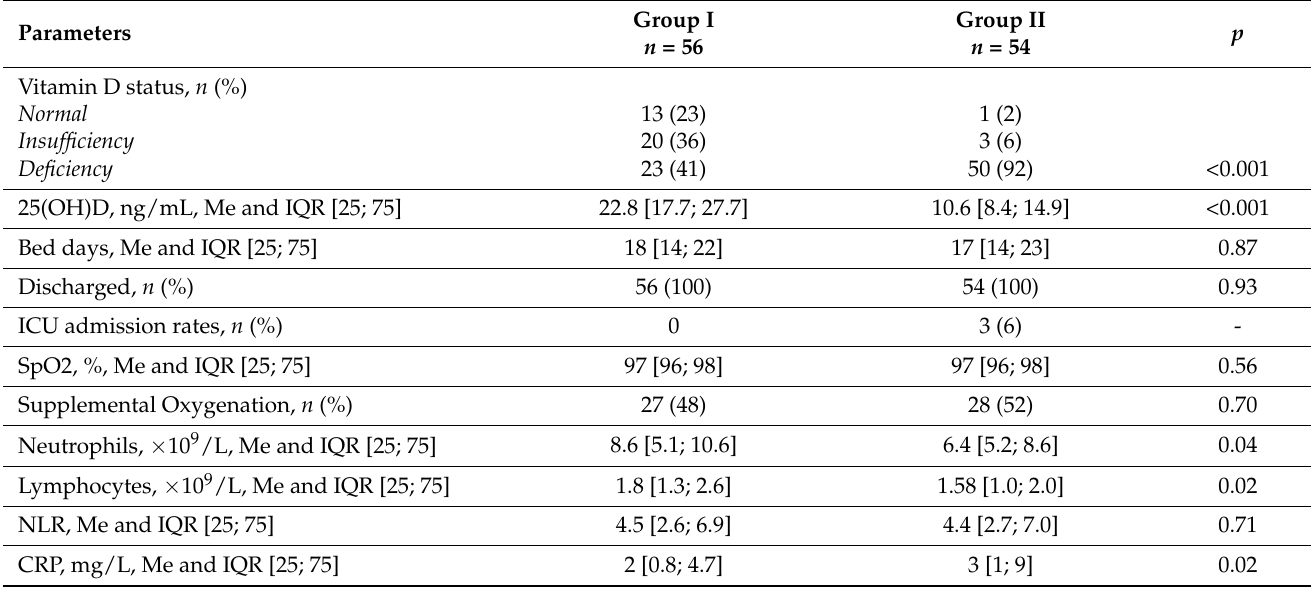
Table 3. Patients’ characteristics on the 9th day of hospitalization ( n = 110).